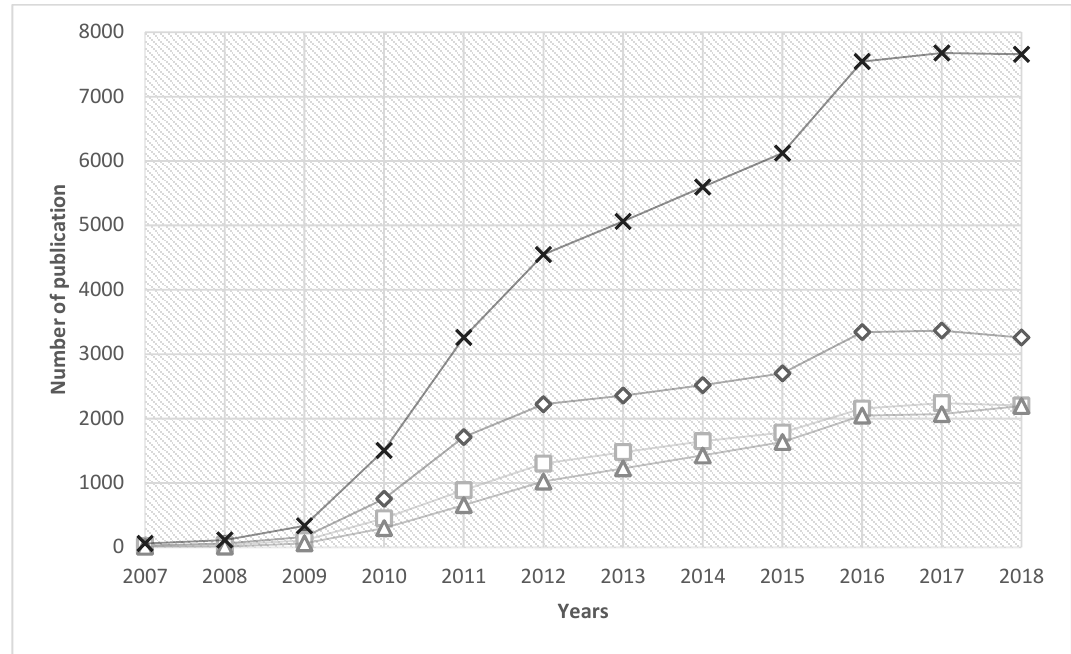
Figure 2. Yearly number of publications found in Scopus using the search term ’ smart grid ’ and the three layers classification.